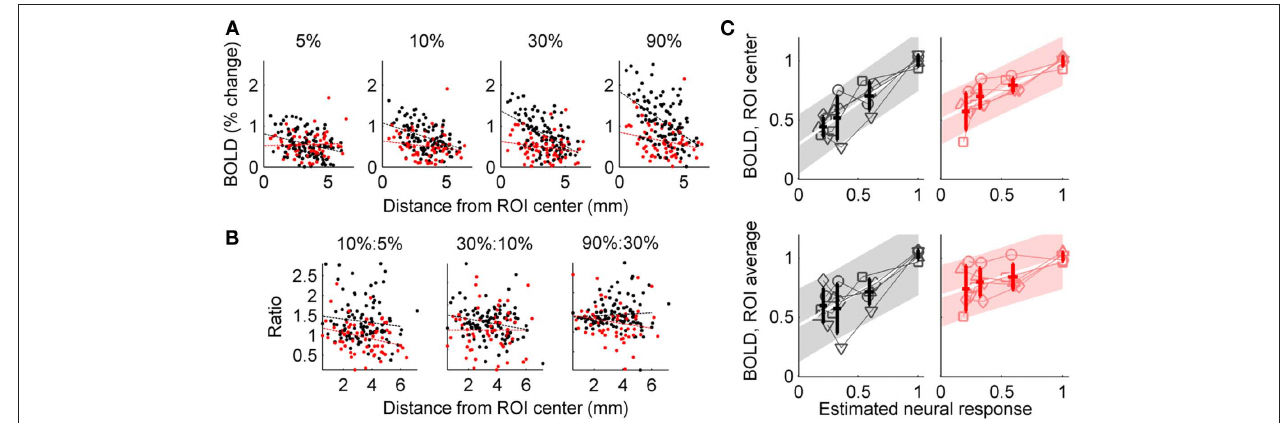
estimates of the neural response. Thin lines indicate individual subject data; bold points indicate average BOLD response ( ± SD), with abscissa coordinate determined by average estimated neural response (mean ± SD). Shaded region indicates 95% confidence interval for linear regression. Top: BOLD response amplitude estimated from the y -intercept of the linear fit to amplitude as a function of distance from the center of the cortical representation of the Gabor patch; bottom: BOLD response estimated as the average of the voxel responses (ignoring spatial location). Left: GE BOLD responses; right; SE